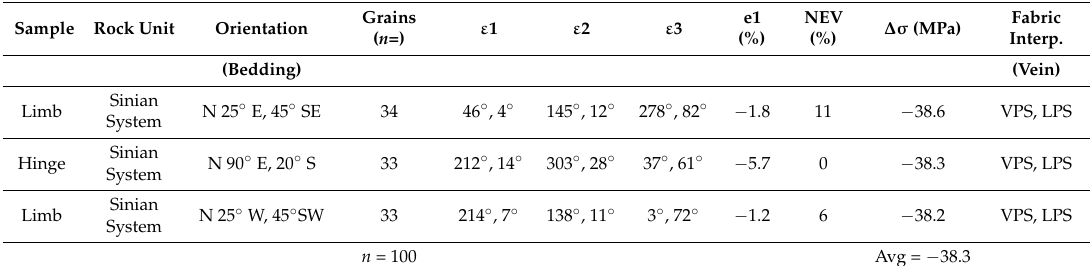
Table 1. Synfolding Calcite Twinning